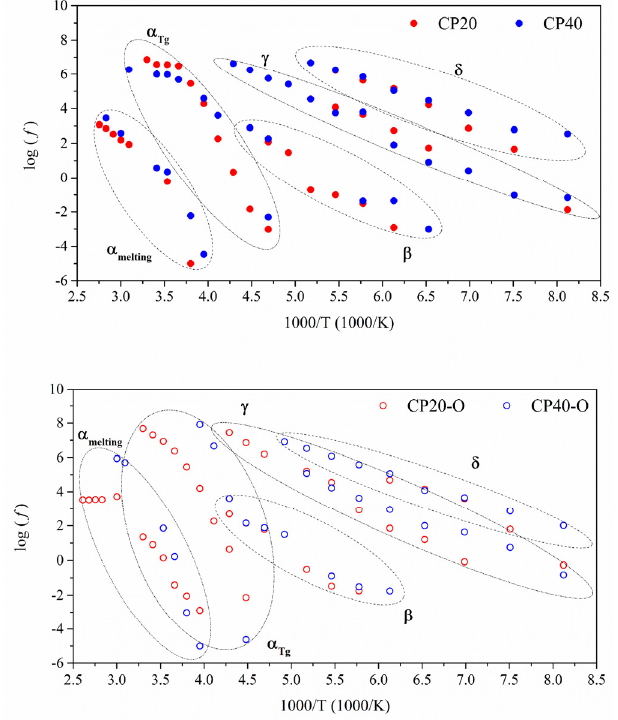
Figure 7. Arrhenius map for the unoriented (full symbols) and oriented (hollow symbols) modified copolymers.